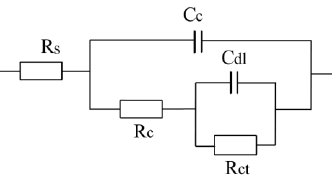
Figure 3. The two-time constant electrical equivalent circuits for porous coating [5,12,21].